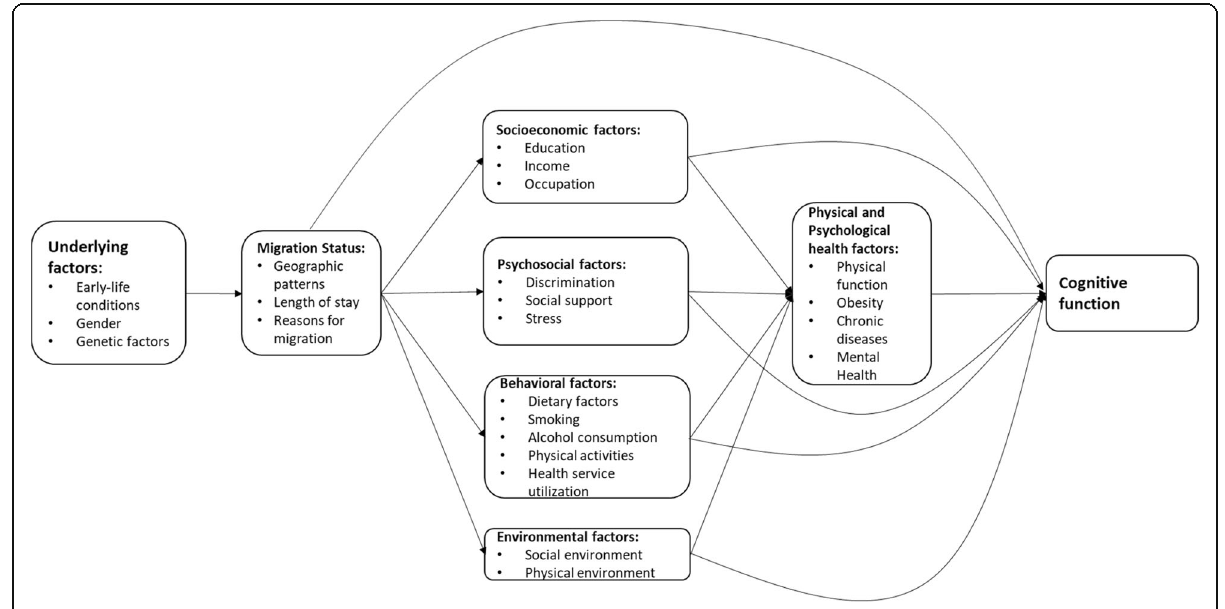
Fig. 1 Conceptual Framework of Potential Mechanisms to Explain the Relationships between Migration and Cognitive